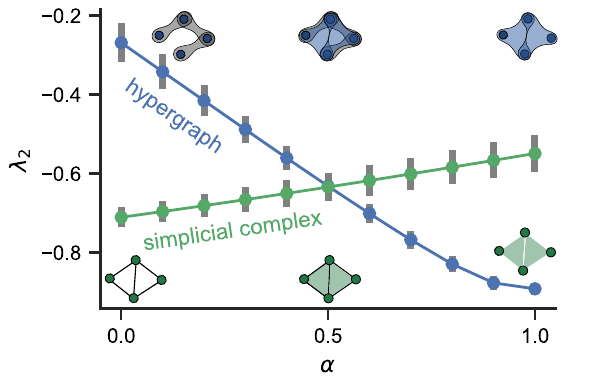
Fig. 1 | Synchronization is enhanced by higher-order interactions in random hypergraphs but is impeded in simplicial complexes. The maximum transverse Lyapunov exponent λ 2 is plotted against α for random hypergraphs (blue) and simplicial complexes (green). As α is increased, the coupling goes from fi rst-order- only( α =0)tosecond-order-only( α =1).Eachpointrepresentstheaverage over50 independent hypergraphs or simplicial complexes with n =100 nodes. The error bars represent standard deviations. We set p = p △ =0.1 for random hypergraphs and p =0.5 for simplicial